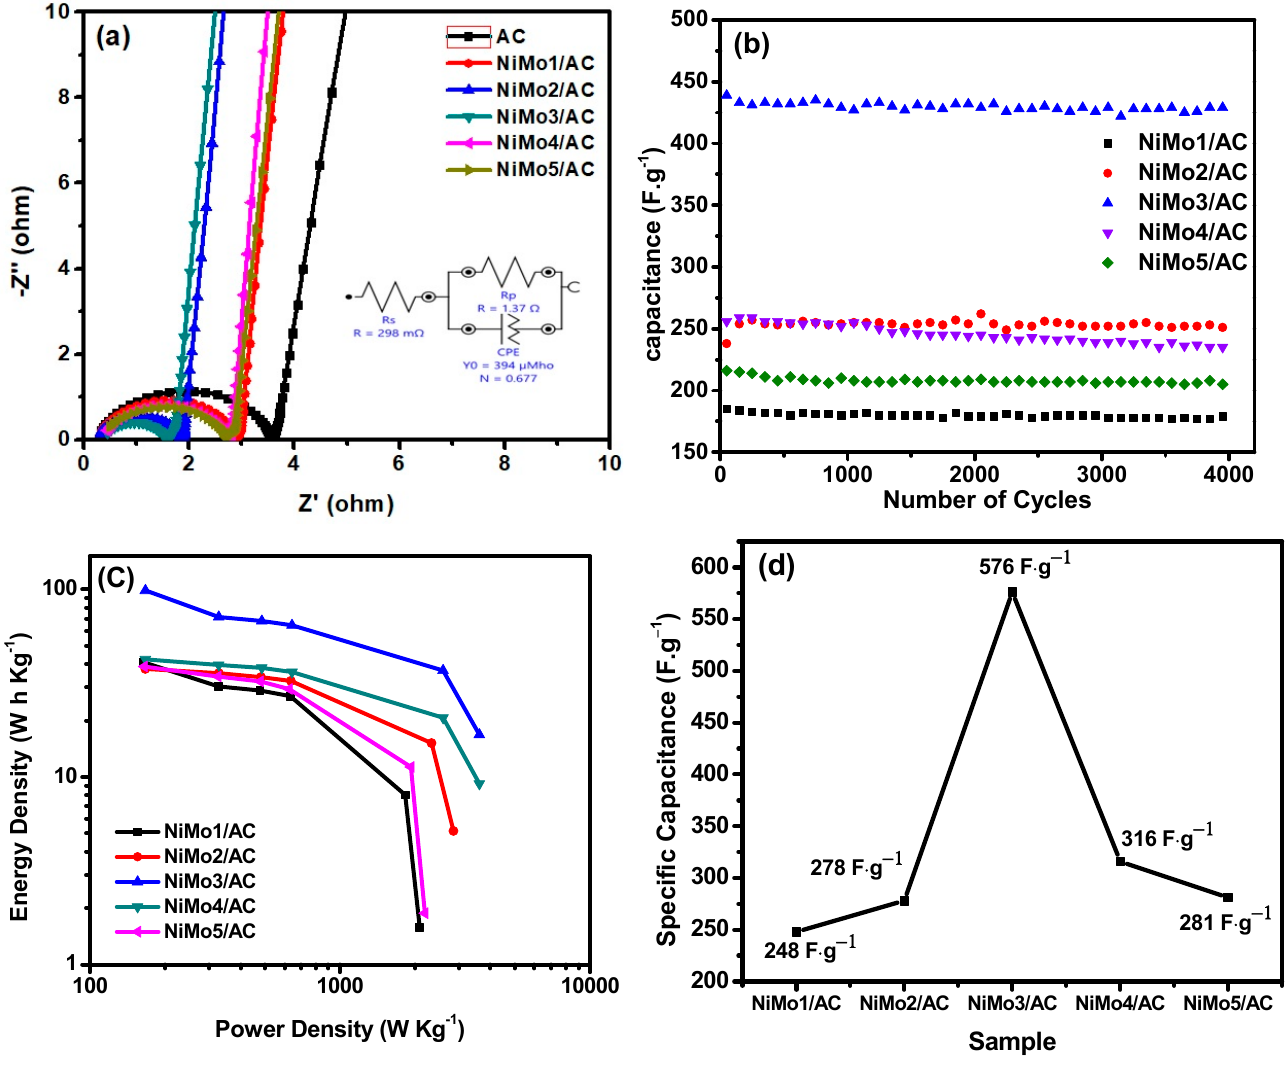
Figure 11. ( a ) EIS, ( b ) 4000th cyclic stability, ( c ) ragone plot, and ( d ) the change of specific capacitance with Ni-Mo ratio.